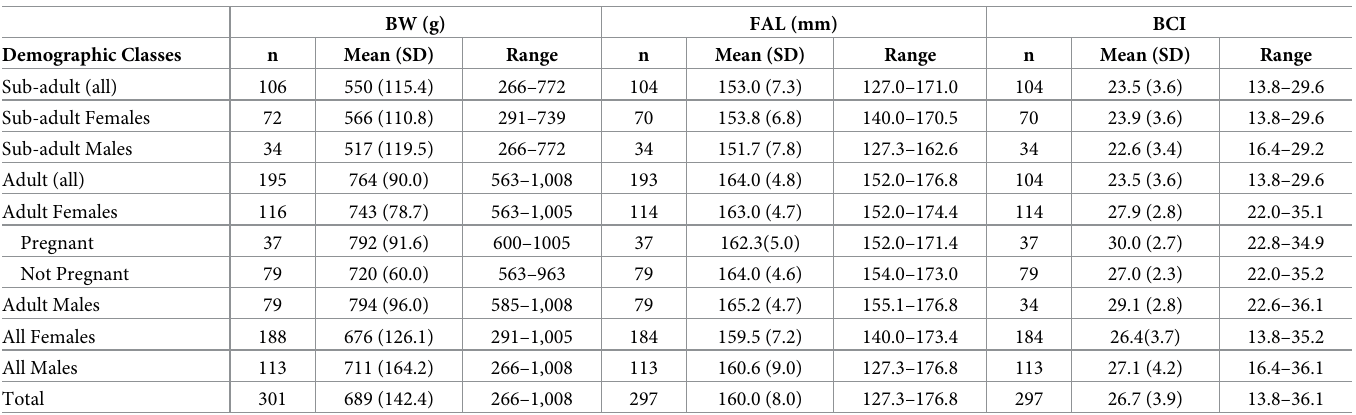
Table 1. Summary demographic statistics–all